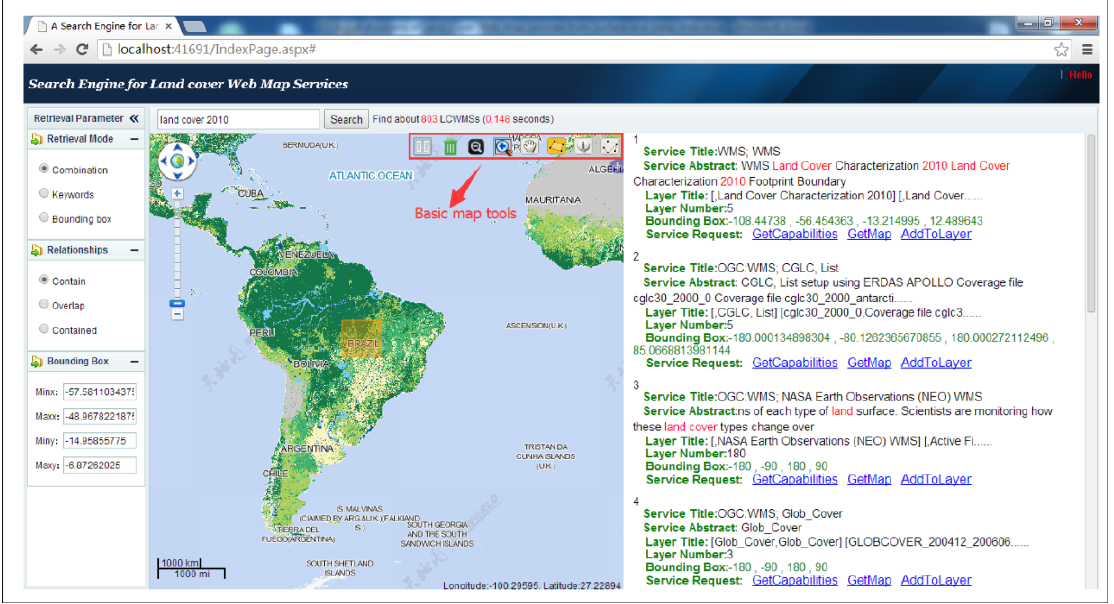
Figure 8. The user query interface to display land cover web map services.